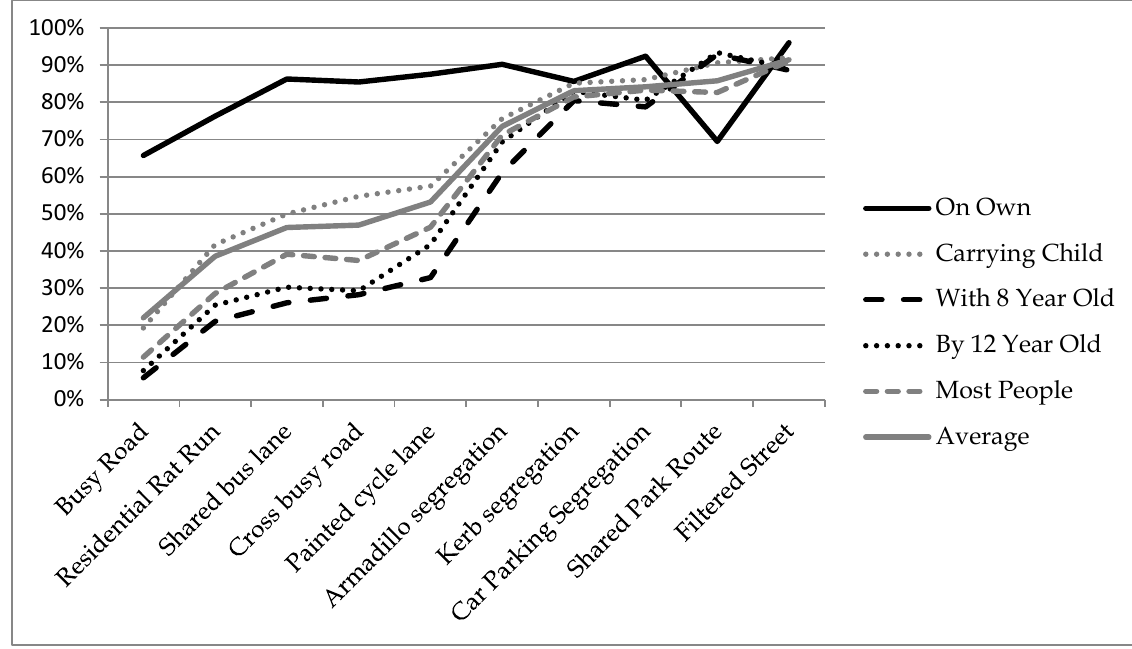
Figure 1. Preferences by situation and scenario Statistical tests were run on both the original Likert-scale variables (Friedman test) and on the recoded binary variables (Cochran’s Q) to establish whether differences were statistically significant. For each set of variables, this involves (a) testing each set of five scenarios, per situation and (b) testing each set of ten situations, per scenarios. For example, (a) asked whether attitudes towards a busy road differed depending on who was cycling, and (b) asked whether attitudes towards the situations differed, when carrying a child. All tests were significant at the 0.01 level; however, this does not indicate whether an individual comparison is significant. The next stage of the testing covered paired comparisons within each situation; so for example, does someone’s attitude towards a busy road differ specifically when carrying a child, compared to riding on their own. These tests were carried out using the Wilcoxon Signed Ranks test (Likert scaled variables) or McNemar’s test (binary variables). Likert variables: 79 out of the 90 comparisons were significant to the 0.01 level; the exceptions and their significance levels are listed below (in ascending